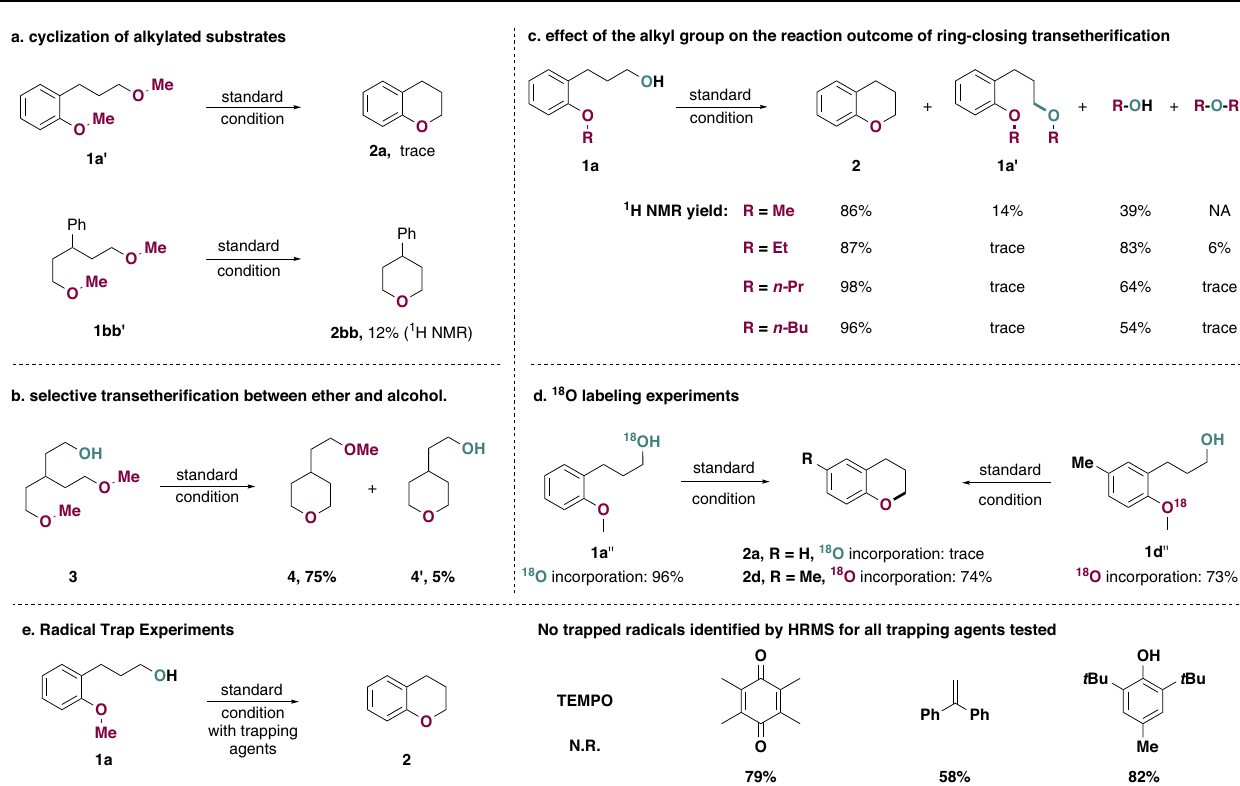
Fig. 4 | Mechanistic experiments. a Cyclization of alkylated substrates. b Cyclization of substrates with multiple ethers that can have manifold reaction modes. c Analyzing the yields of products and byproducts of the reaction by changing the alkyl groups of ether. d 18 O labeling